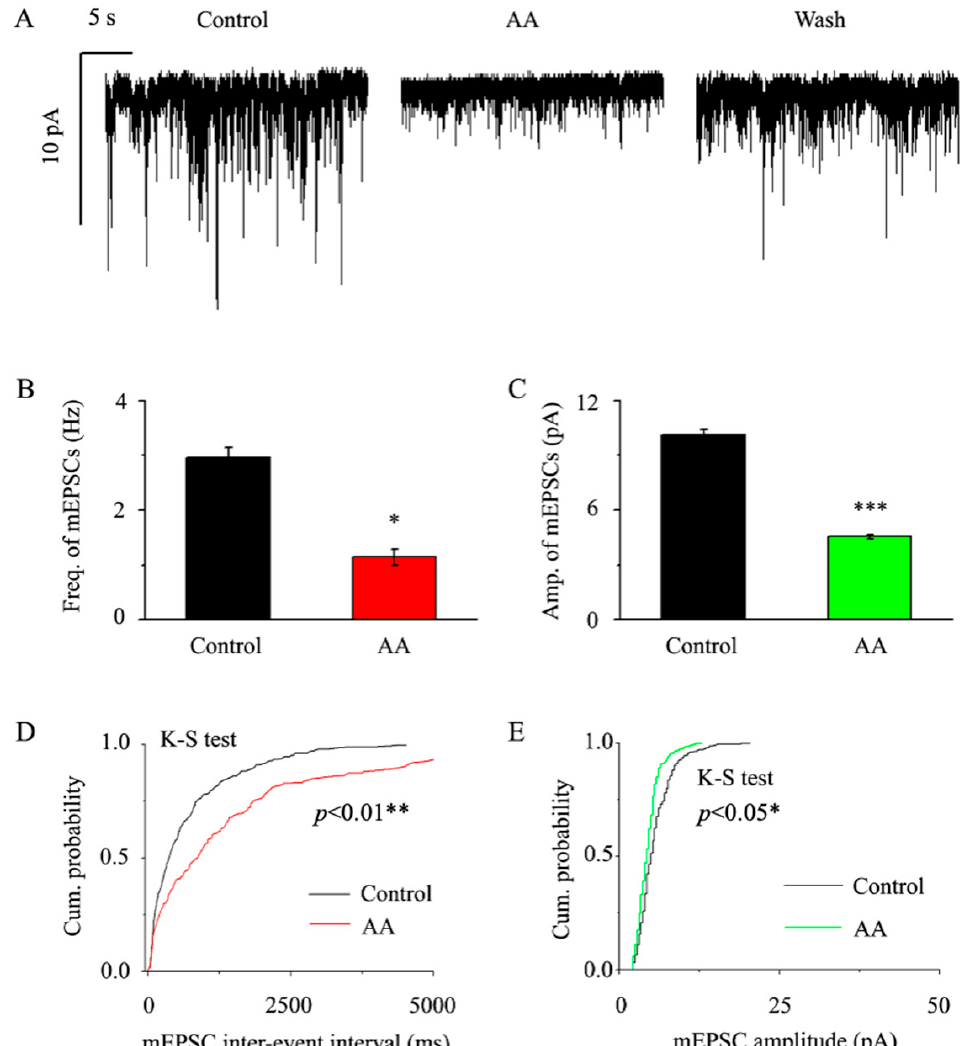
Figure 2. AA decreased the frequency and amplitude of glutamatergic mEPSCs in glaucomatous RGCs. ( A ) Representative large-scale traces depicting the effect of 10 µ M AA on mEPSCs during AA treatment (middle), recovery (right) and control conditions (left). Horizontal scale bar, 5 s; vertical scale bar, 10 pA. ( B , C ) Summarized data (n = 14; from ten slices) on the frequency ( B ) and ampli- tude ( C ) of glutamatergic mEPSCs. ( D , E ) A typical neuron’s cumulative frequency and amplitude distributions of glutamatergic mEPSCs under control and during AA treatment demonstrate that AA dramatically altered the cumulative frequency curve to the right and the cumulative amplitude curve to the left. Student’s paired t test; * p < 0.05, ** p < 0.01 and *** p < 0.001 in comparison to the control